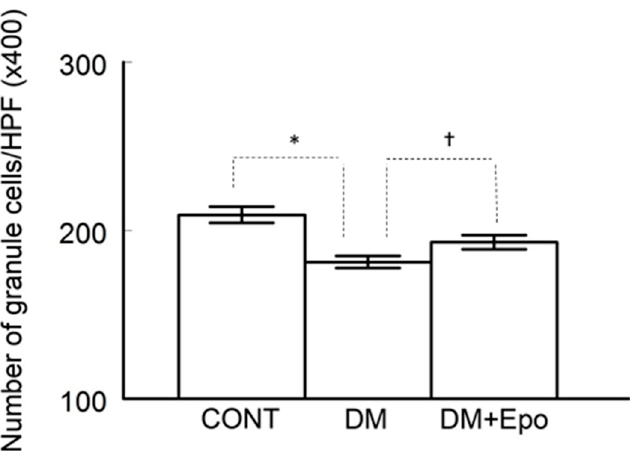
Figure 4. Number of granule cells/high power field (HPF) in the dentate gyrus (DG) was counted and compared among the control (CONT), diabetic (DM) and EPO-treated diabetics (DM+Epo). Counting cell nuclei was done viewing H&E stained sections at 400 magnification in non-overlapping fields of each DG area in serial sections from the three experimental groups. * Number of granule cells was lower in diabetics compared to control ( p < 0.01). † Number of cells was lower in diabetics compared to EPO-treated diabetics ( p < 0.01). Data expressed as mean ± SEM.